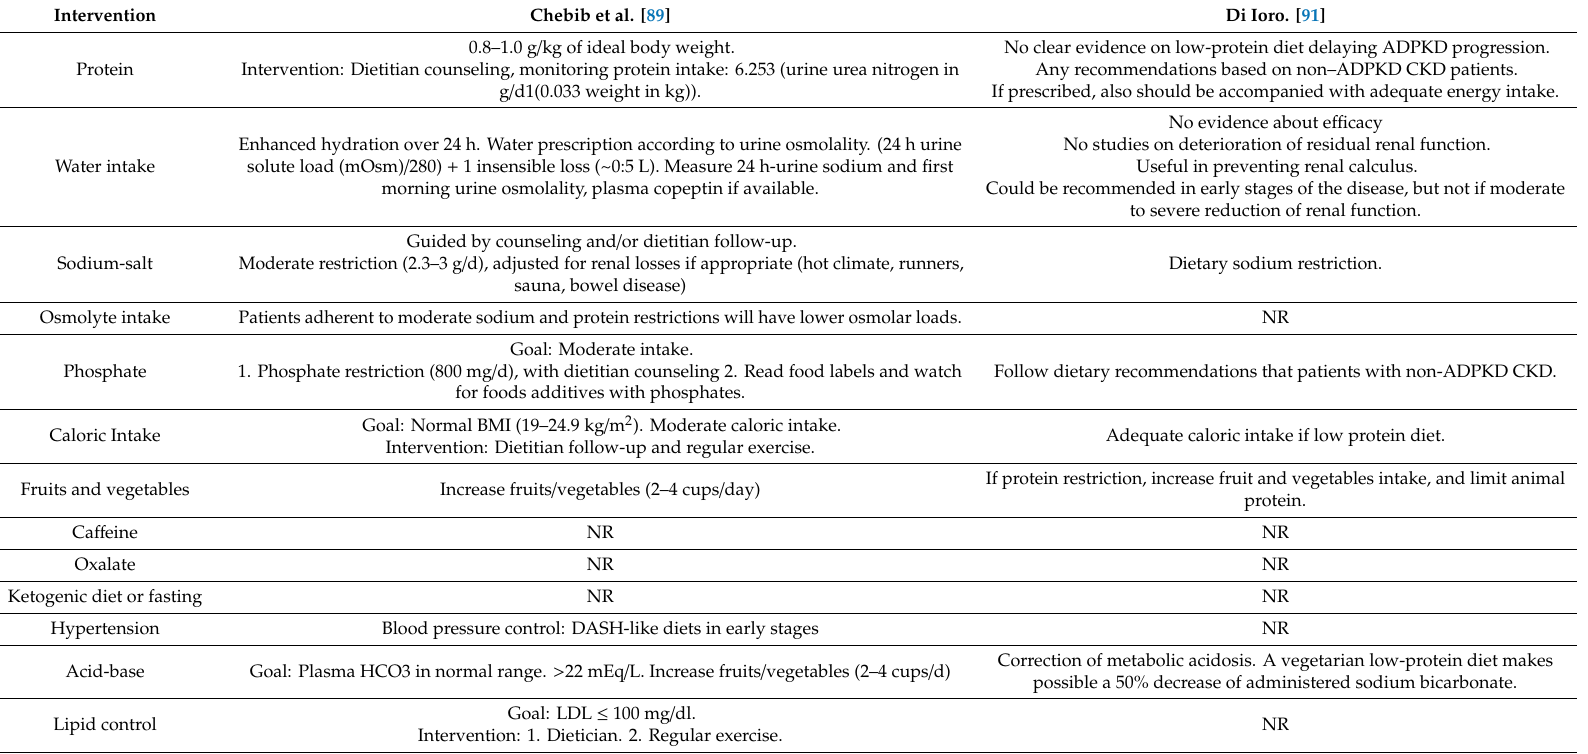
Table A2. What do opinion leaders say about dietary management of ADPKD? Recommendations about drug prescription not shown. Intervention Chebib et al. [89] Di Ioro. [91] Protein